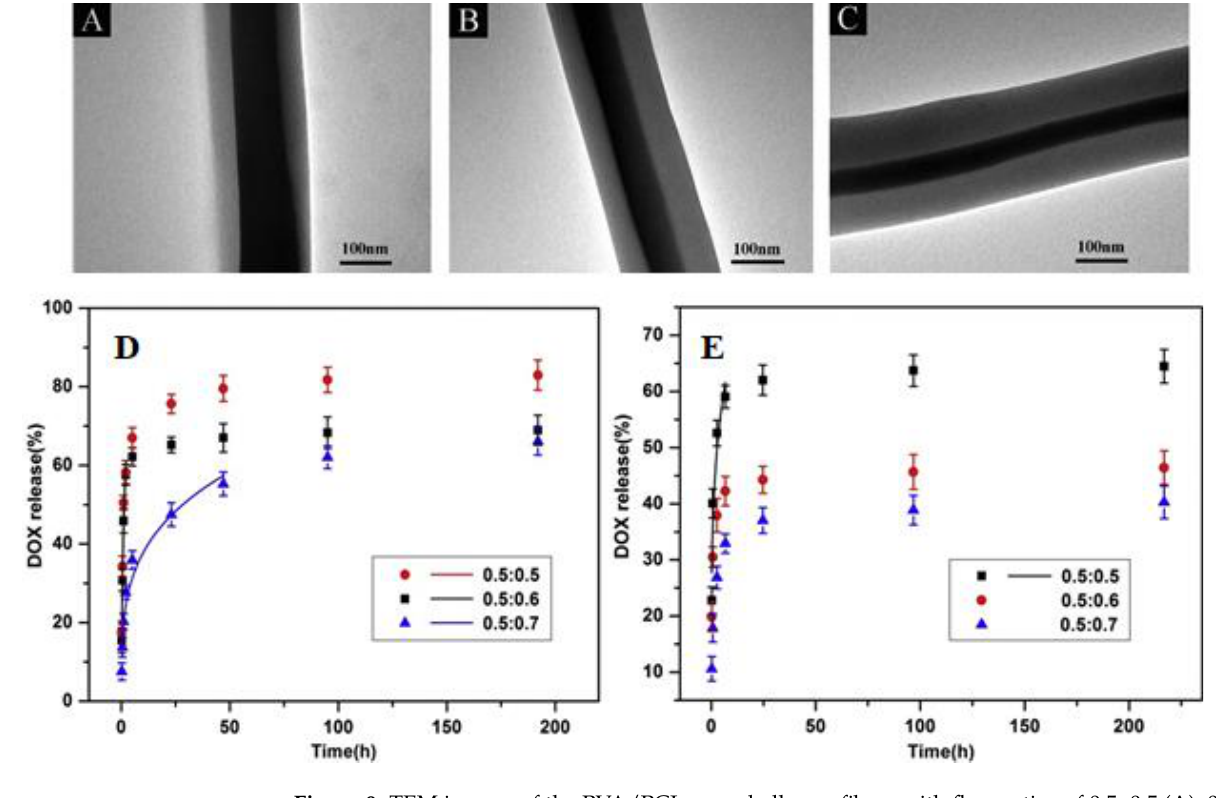
Figure 9. TEM images of the PVA/PCL core-shell nanofibres with flow ratios of 0.5: 0.5 ( A ), 0.5: 0.6 ( B ) and 0.5: 0.7 ( C ), In vitro Drug release profiles of the PVA/PCL core-shell nanofibres in pH = 4 phosphate buffer saline ( D ), and in pH = 7.4 ( E ). Reproduced with permission from [110], copyright 2020 Elsevier. Table 3. Summarised characteristics of studies employing coaxial electrospinning for drug delivery